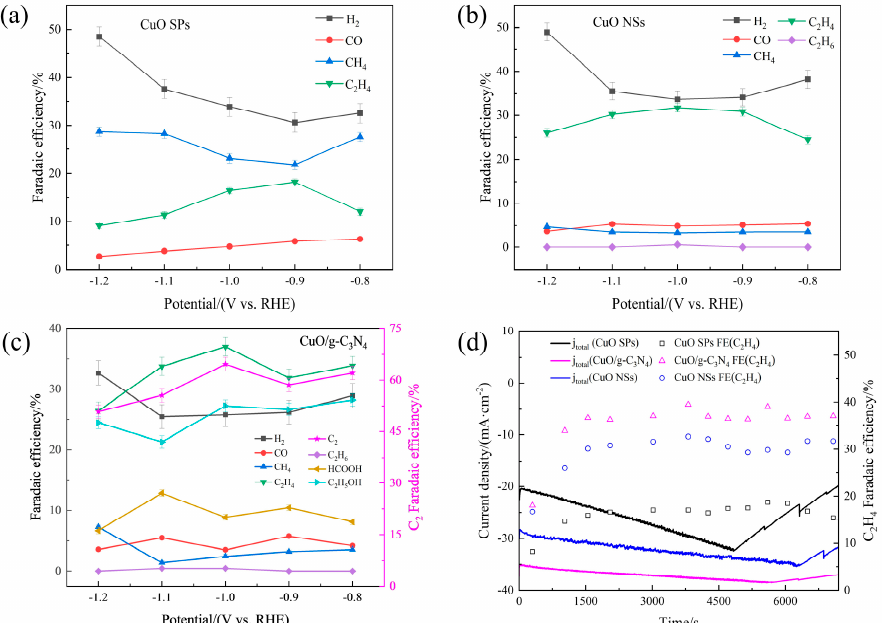
Figure 2. Faradaic efficiencies of CO 2 electroreduction products as a function of the potential: ( a ) CuO SPs, ( b ) CuO NSs and ( c ) CuO/g-C 3 N 4 . ( d ) Stability tests for CuO SPs, CuO NSs and CuO/g-C 3 N 4 at − 1.0 V vs. RHE.